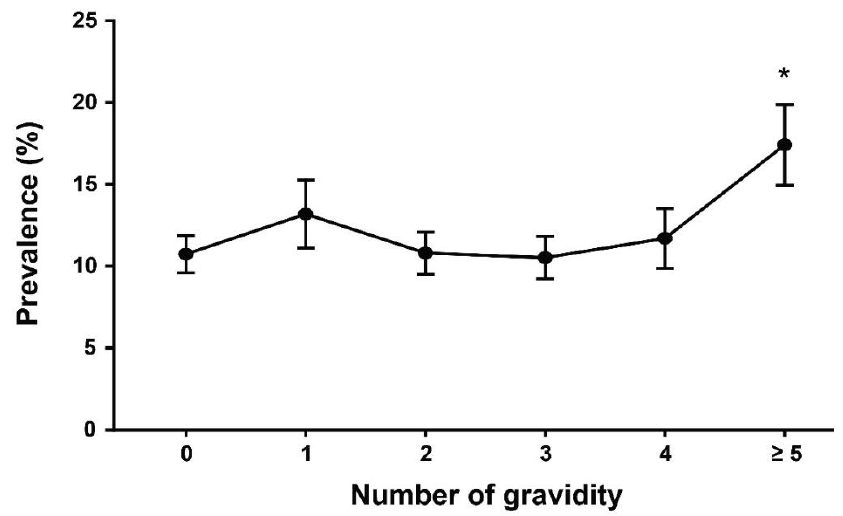
Figure 2. Annual prevalence (95% confidence interval) of OC use according to gravidity. * p < 0.01, compared with the other groups.